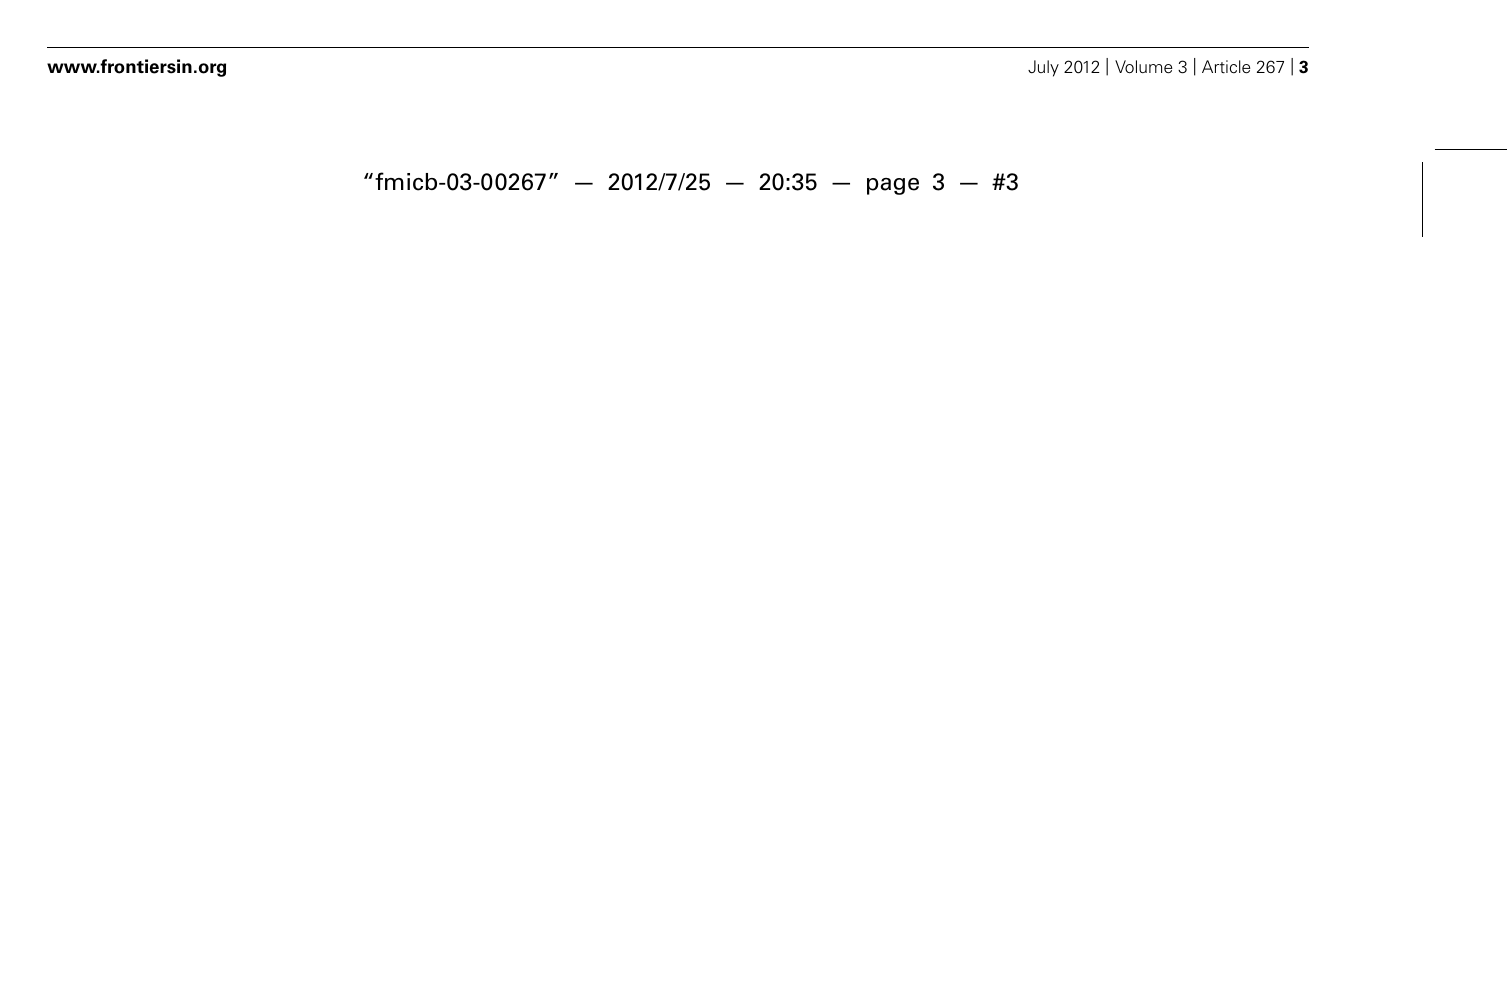
on the basis of previously reported review articles (Holmes etal., 2007; Huthoff andTowers, 2008; Strebel etal., 2009). A3G, APOBEC3G; IN, viral integrase